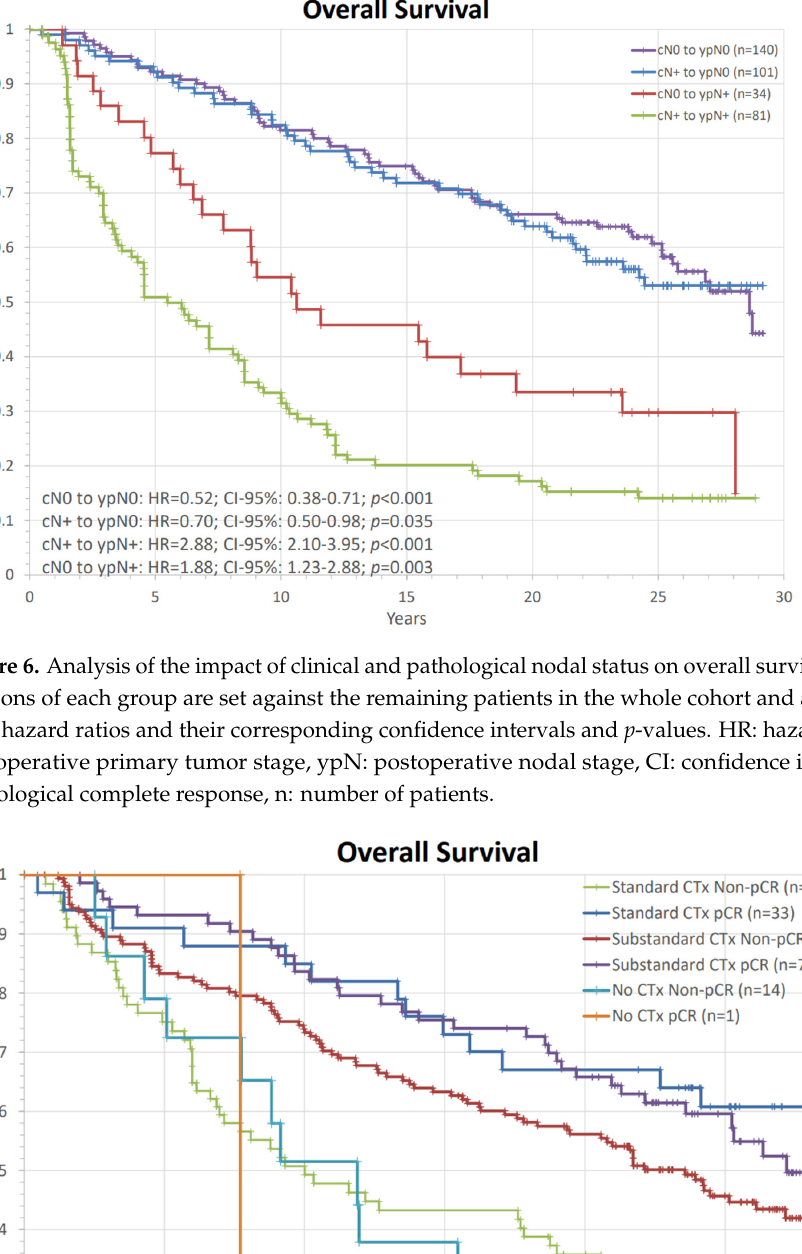
Figure 5. Analysis of survival of different postoperative T-stages and N-stages. The comparisons are presented with hazard ratios and their corresponding confidence intervals and p -values against ypT0/Tis and ypN0. HR: hazard ratio, ypT: postoperative primary tumor stage, ypN: postoperative nodal stage, CI: confidence interval, n: number of patients.